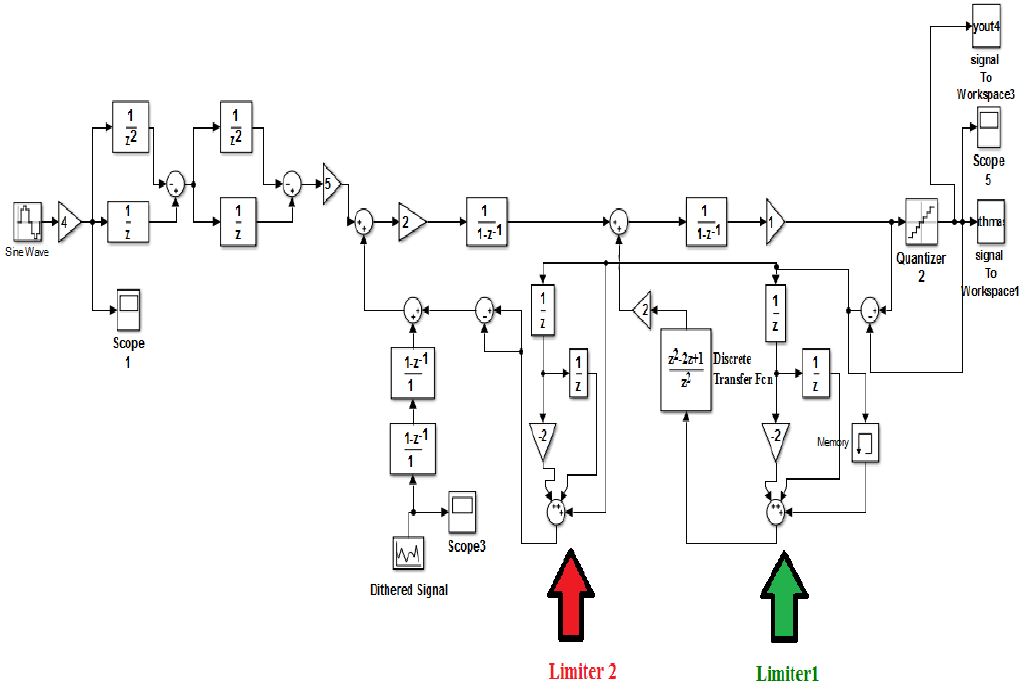
Figure 7. Simulink Model of Hybrid MASH-EFM Architecture.